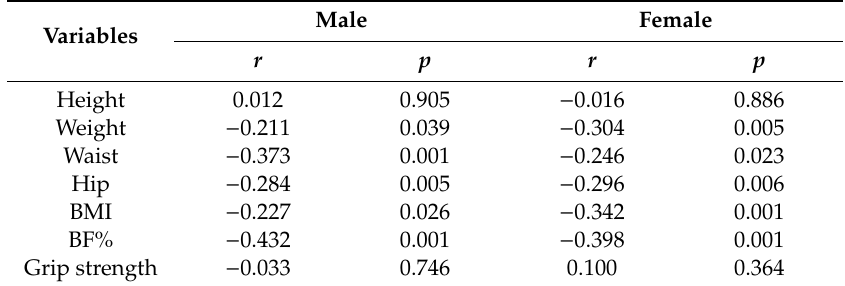
Table 3. Correlation results between physical activity level (PAL) and other variables by gender. Male Female Variables r p r p Height 0.012 0.905 Weight −